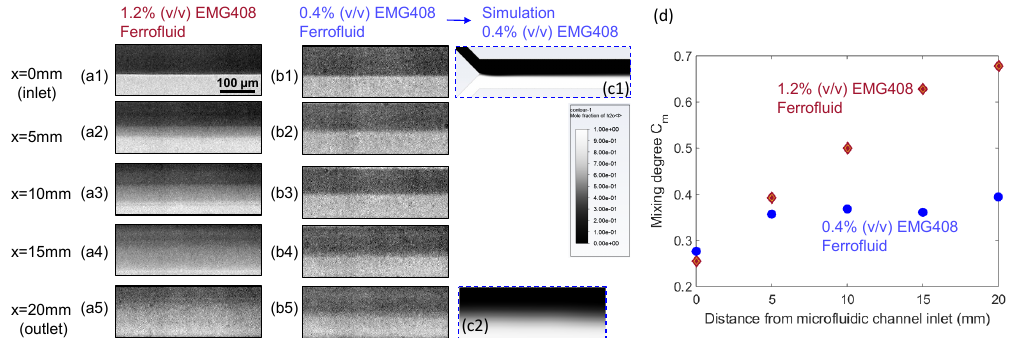
Figure 7. E ff ect of the concentration of ferrofluid on the mixing performance. Group ( a , b ) are the original experimental fluids distribution at di ff erent positions of the microfluidic channel under the e ff ect of magnetic field generated by embedded micromagnet when the magnetic nanoparticles concentration of EMG 408 ferrofluid is 1.2% (v / v) and 0.4% (v / v). The total flow rate is 0.4 mL / h and the flow rate ratio between ferrofluid to water is 1:1 for both groups of ( a , b ). In ( c ), ( c1 , c2 ) are the simulated results corresponding to ( b1 , b5 ), respectively. ( d ) is the e ff ect of ferrofluid concentration on mixing degree corresponding to group ( a , b